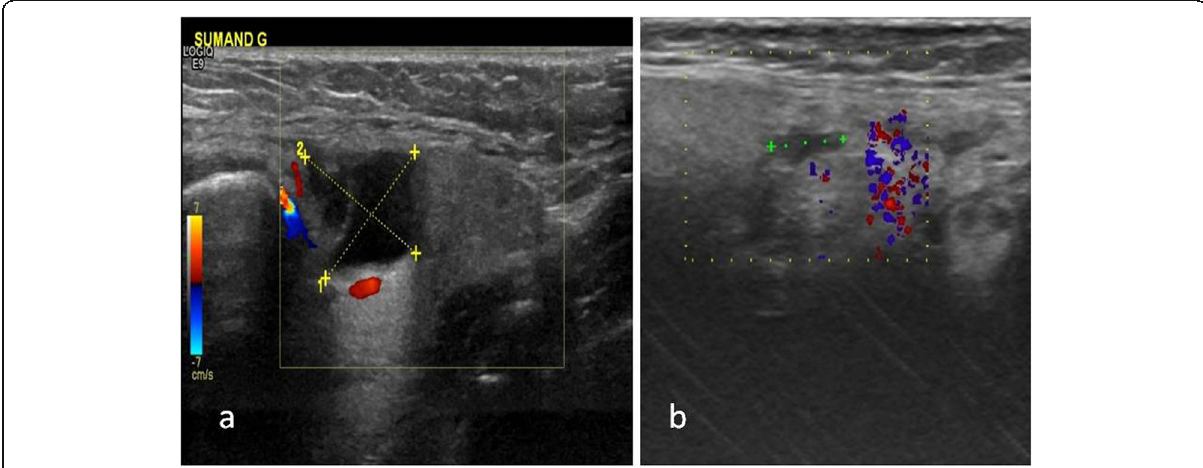
Fig. 4 Cervical color Doppler ultrasound: intermediate result 1 month after a session of sclerotherapy ( a ) and final outcome 4 months later ( b